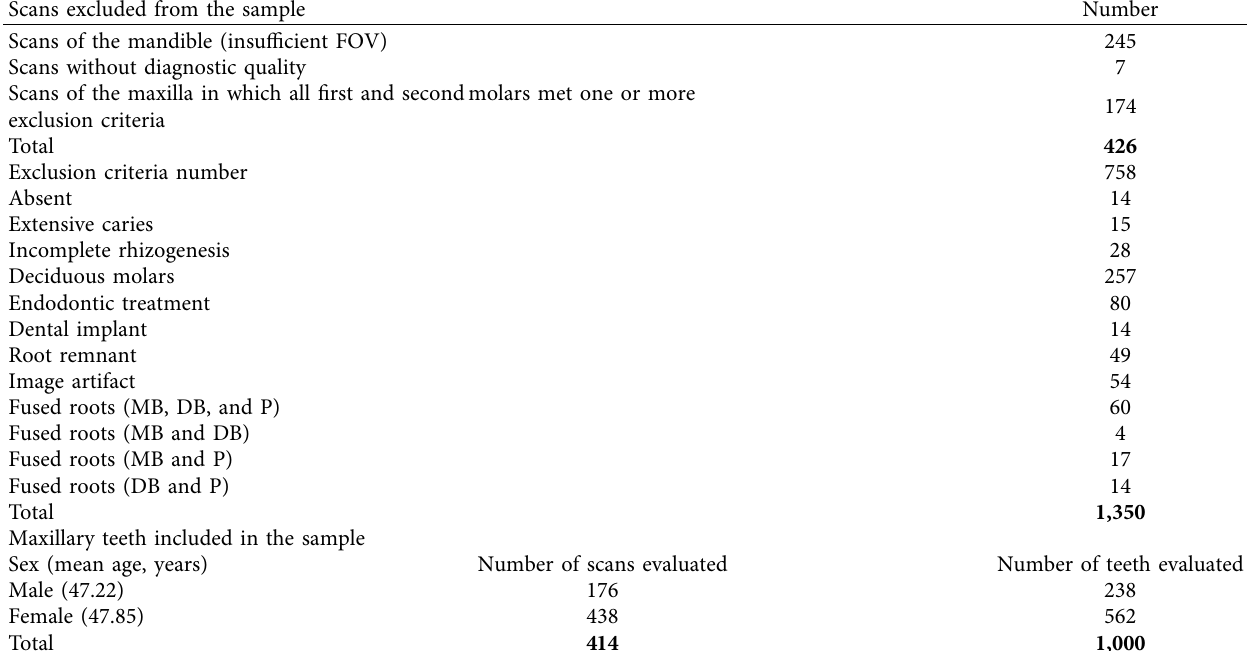
Table 1: Scans excluded from the sample, maxillary teeth excluded and included from the sample Scans excluded from the sample Scans of the mandible (insufficient FOV) Scans without diagnostic quality Scans of the maxilla in which all first and secondmolars met one or